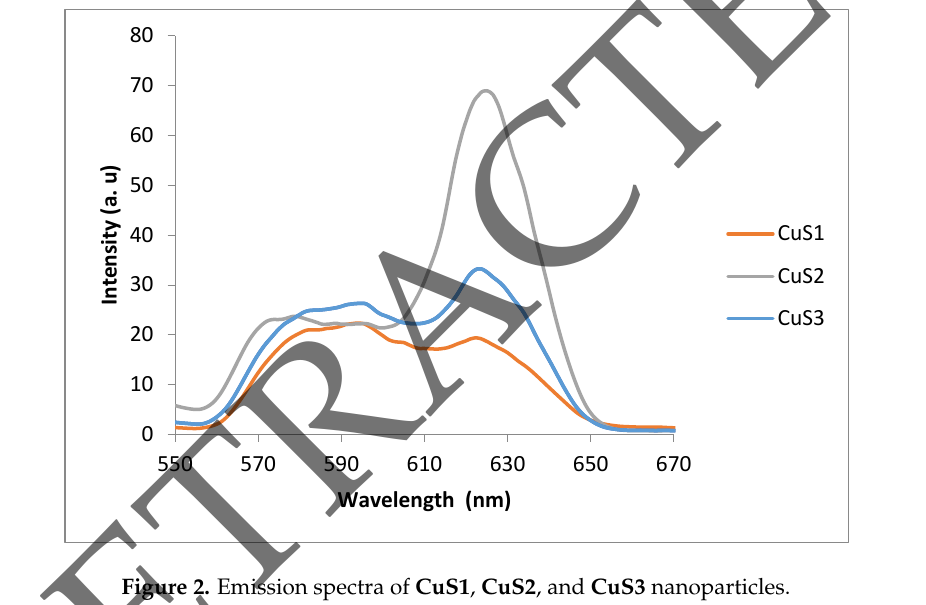
Figure 2. Emission spectra of CuS1 , CuS2 , and CuS3 nanoparticles.